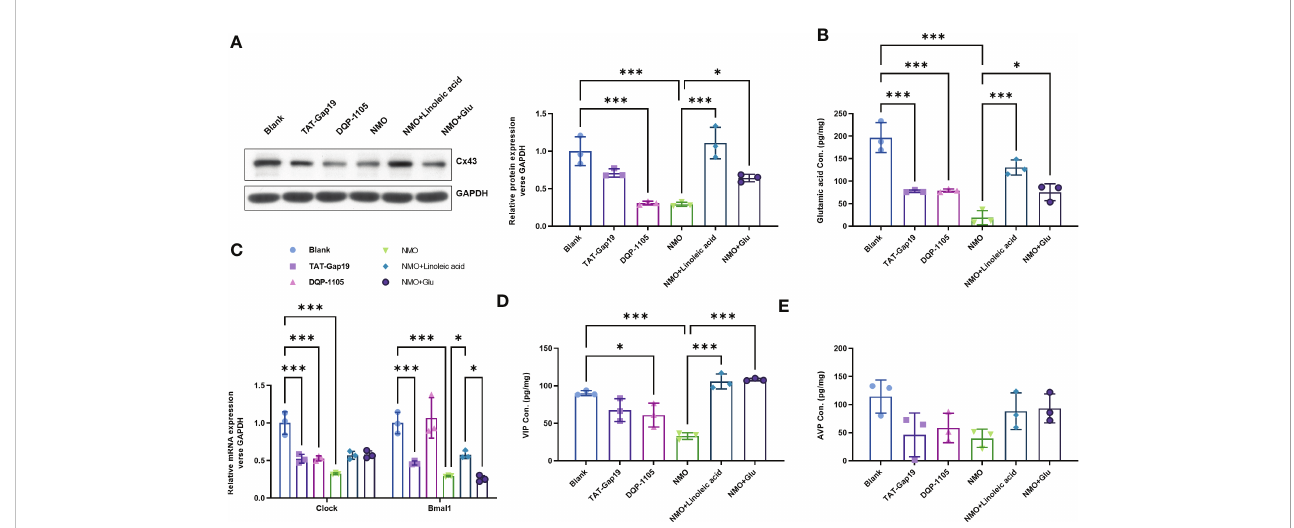
FIGURE 4 Cx43-glutamate signaling inhibition contributes to the NMO-induced circadian rhythm dysregulation. (A) The protein level of Cx43 in normal astrocytes with or without TAT-Gap19/DQP-1105 or NMO astrocytes with or without LA/glutamate were analyzed by Western Blot. (B) The glutamate levels in normal astrocytes with or without TAT-Gap19/DQP-1105 or NMO astrocytes with or without LA/glutamate were analyzed by ELISA kit. (C) The mRNA levels of Clock and Bmal1 in normal astrocytes with or without TAT-Gap19/DQP-1105 or NMO astrocytes with or without LA/glutamate were analyzed by real-time PCR. The protein level of AVP (D) and VIP (E) were detected by ELISA kits. * P <0.05, *** P <0.001, compared with the indicated group.